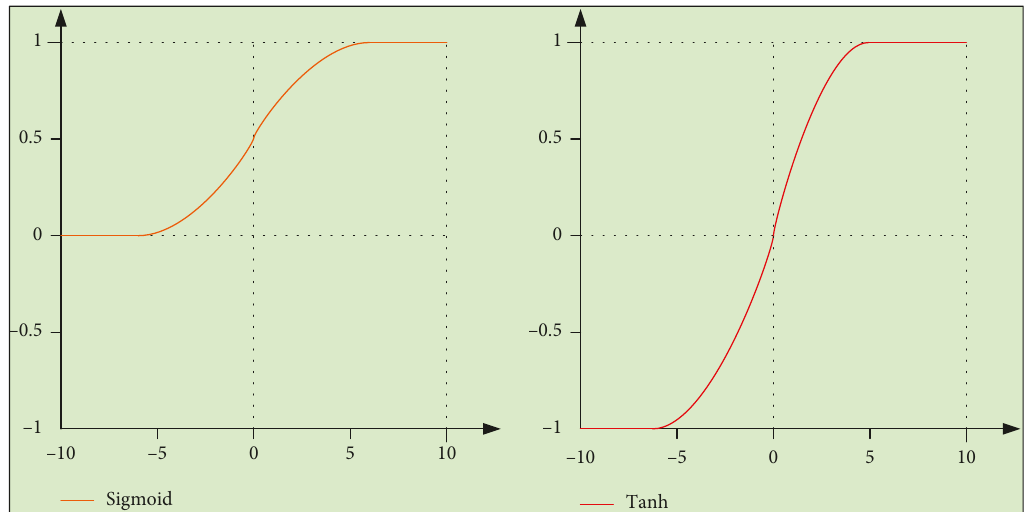
Figure 4: Figure of sigmoid and Tanh functions.